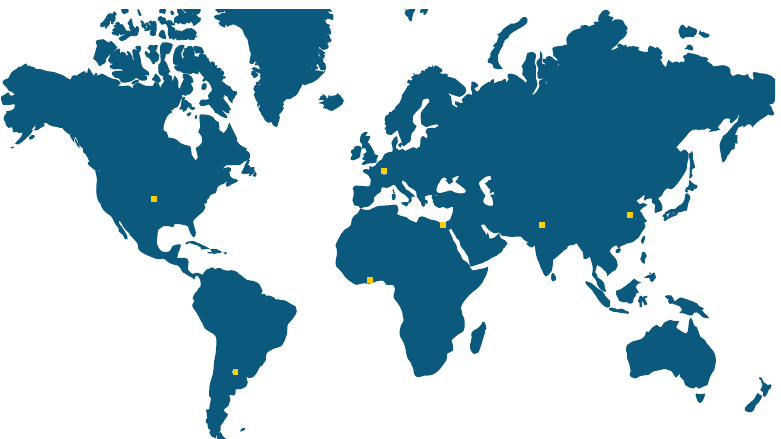
Figure 3. Schematic geographical position of the seven analysed areas in Argentina, Egypt, China, France, Ghana, India and USA.